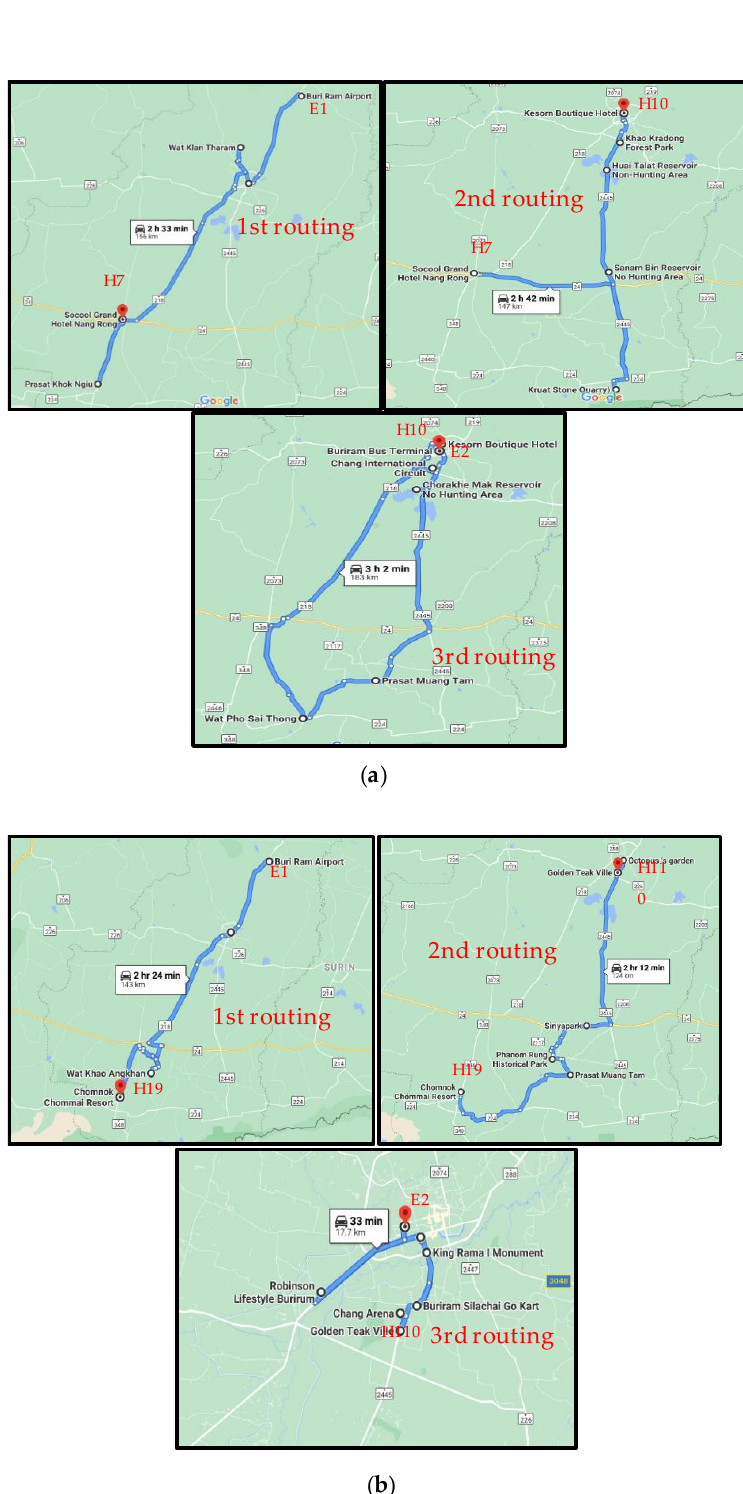
Figure 11. Routing case study ( a ) Family tourism routing. and ( b ) Non-family tourism routing.